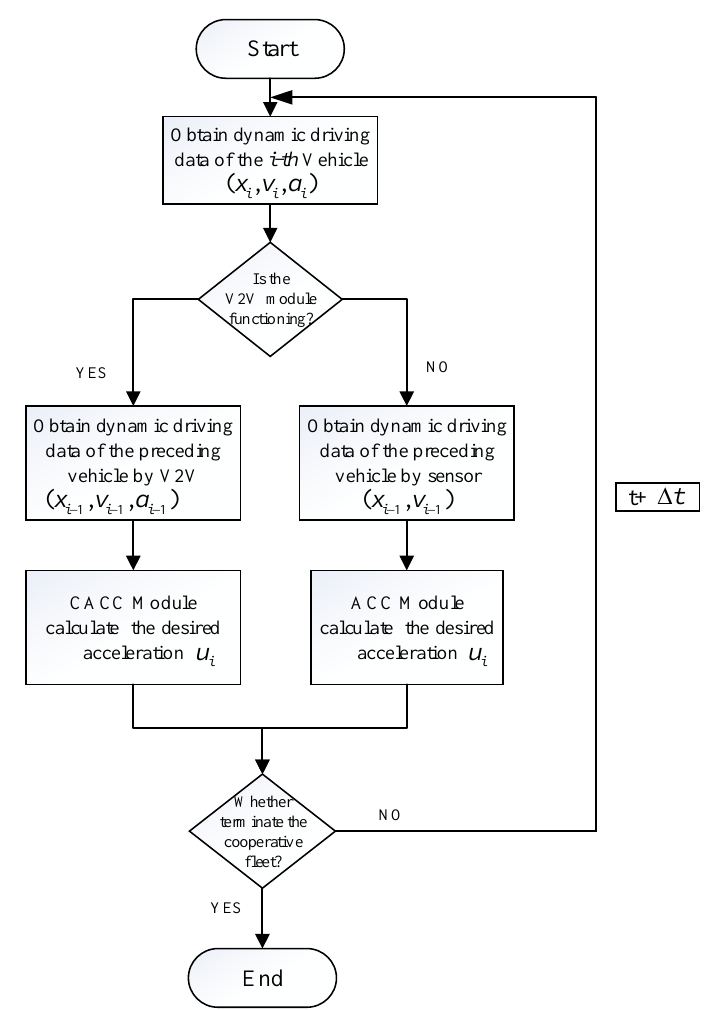
Figure 3. Schematic of a heterogeneous CACC vehicle platoon.